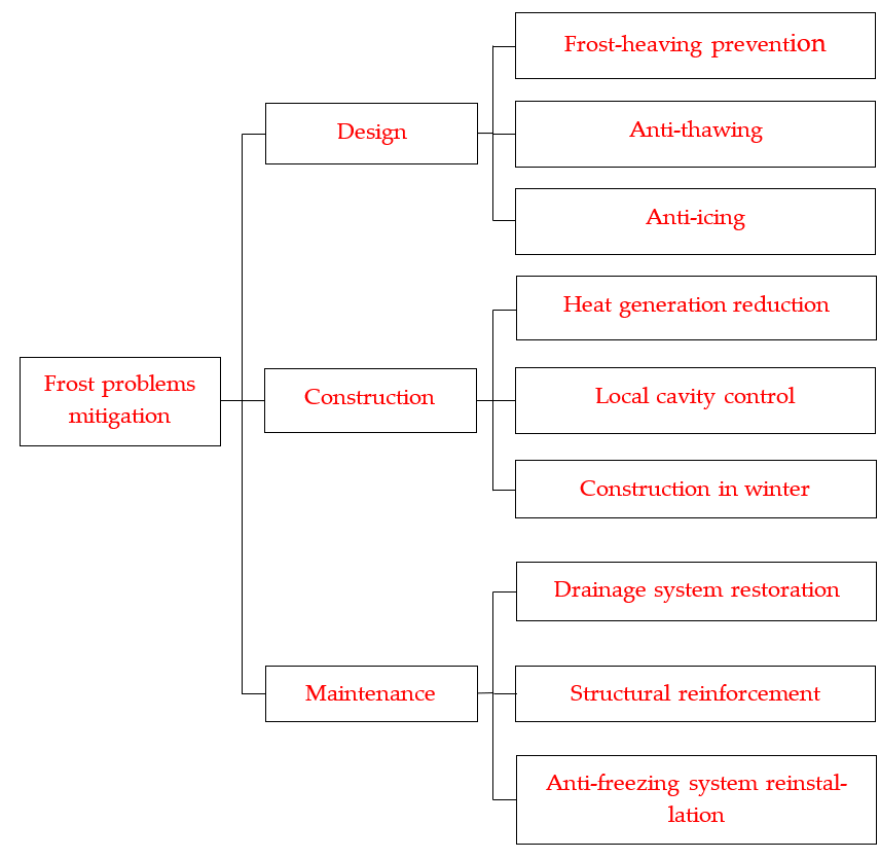
Figure 1. Frost-problem mitigation